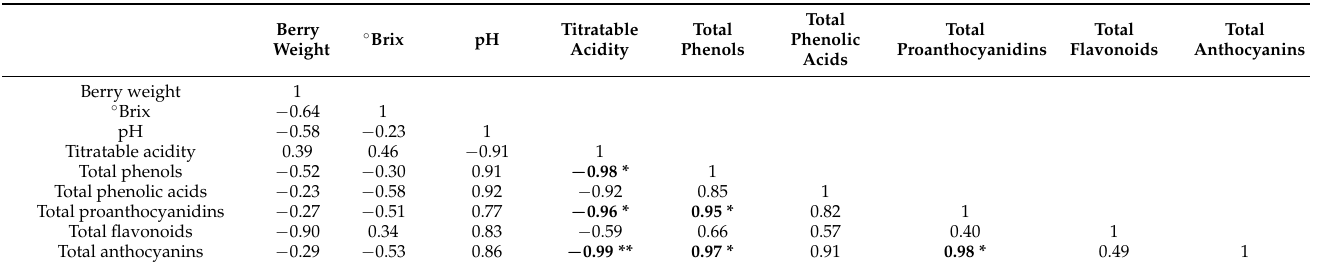
Table 2. Matrix of the correlations between berry parameters of Beibinghong vines subjected to different treatments: (i) leaf removal at v é raison, (ii) potassium (K + ) foliar application, and (iii) leaf removal + K + foliar application, as well as the control (above the